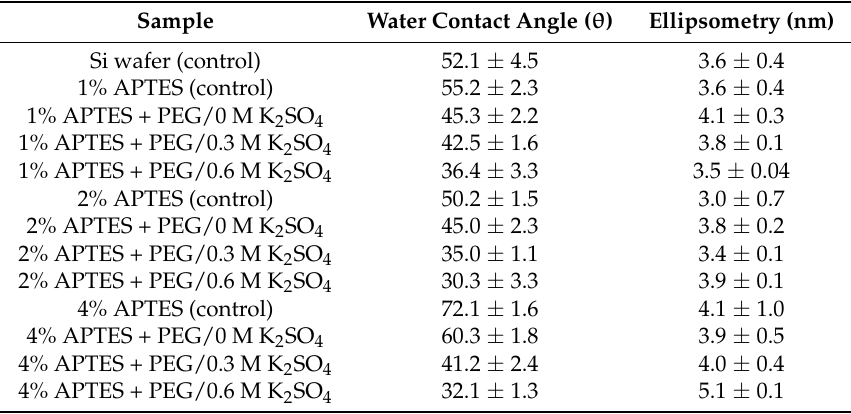
Table 4. Water contact angle and ellipsometry measurements of BSA adsorbed on modified surfaces at 60 ◦